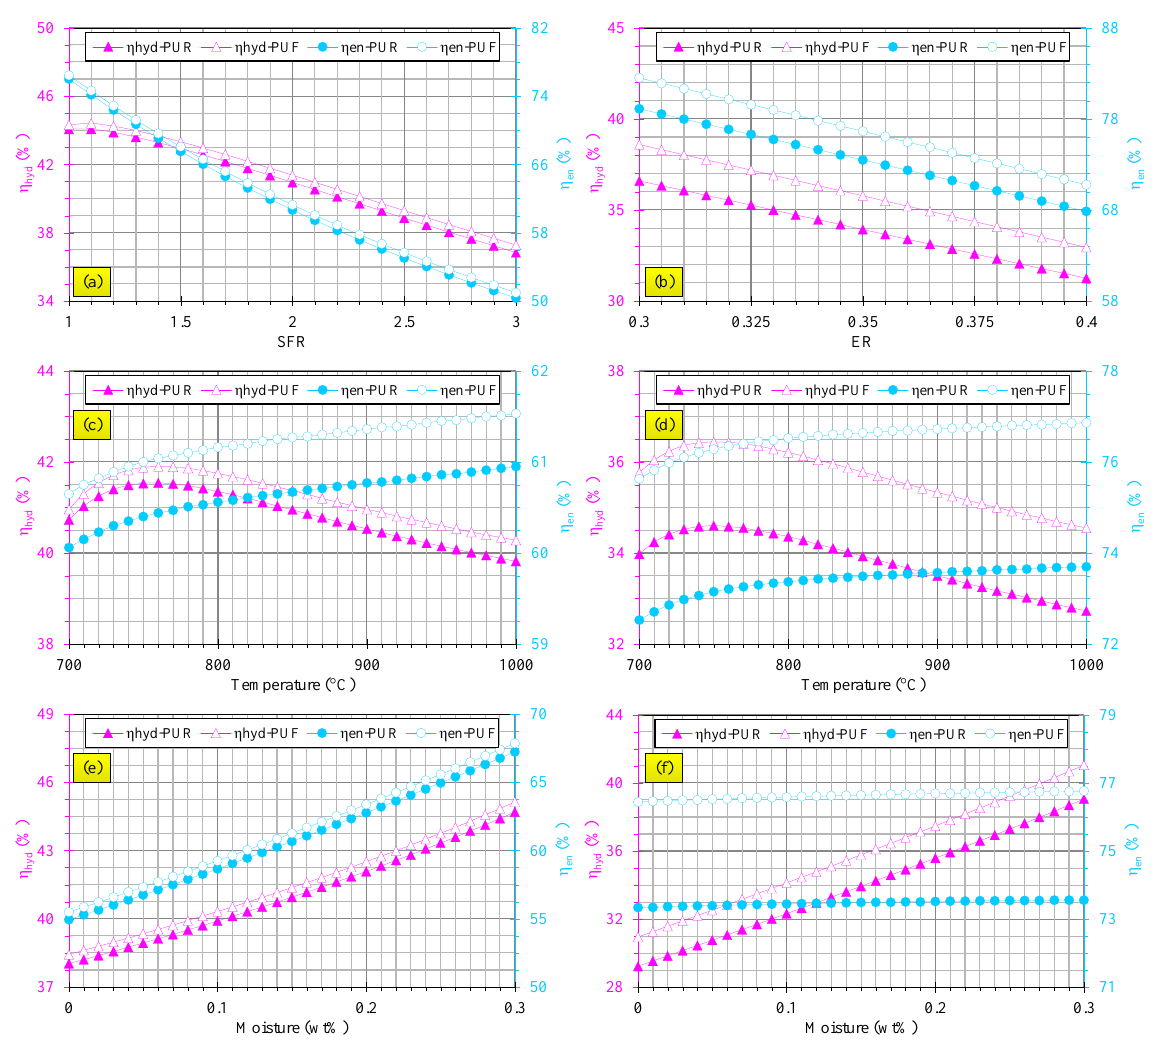
Figure 5. Effects of gasification parameters on energy and hydrogen efficiencies. ( a ) Effects of moisture content of waste flexible and rigid PU foams in steam gasification, ( b ) effects of moisture content of waste flexible and rigid PU foams in air gasification, ( c ) effects of temperature in steam gasification, ( d ) effects of temperature in air gasification, ( e ) effects of steam/waste PU foam ratio in steam gasification and ( f ) effects of equivalence ratio in air gasification.